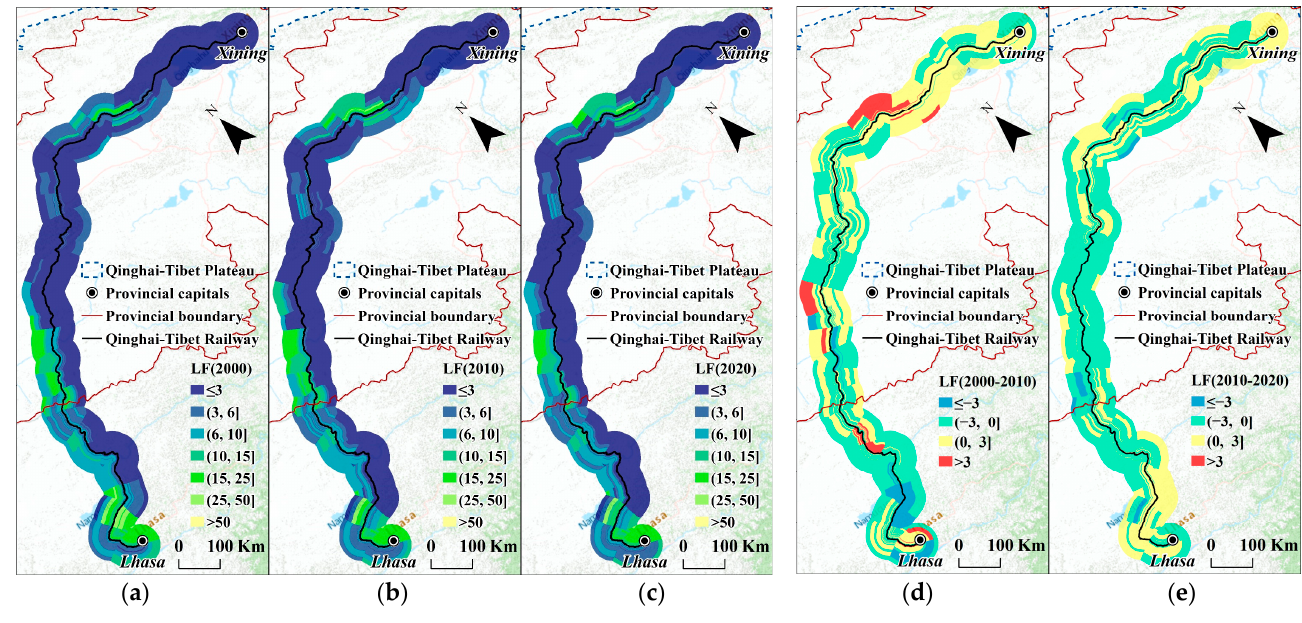
Figure 4. LF of 32 railway sections and different sides. ( a ) LF in 2000; ( b ) LF in 2010; ( c ) LF in 2020.